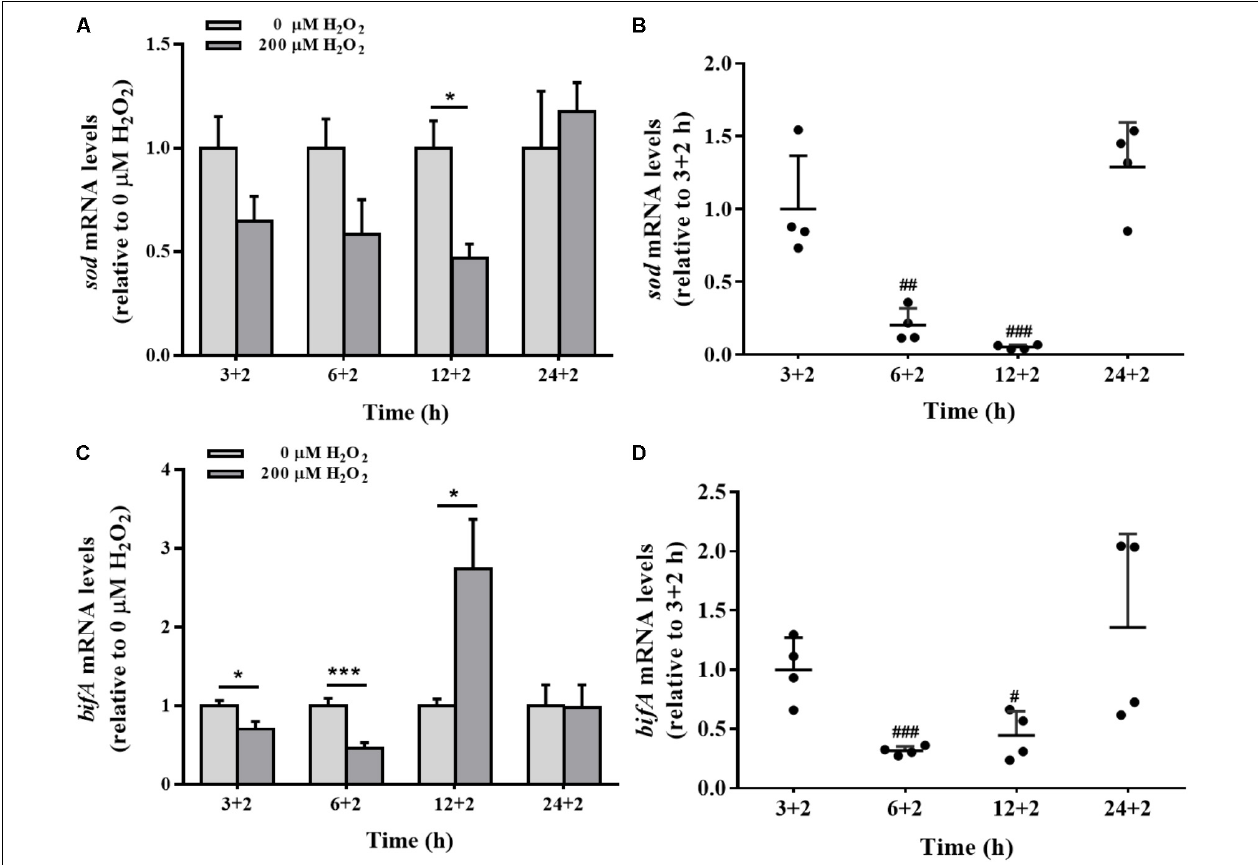
FIGURE 6 | The sod and bifA mRNA levels in biofilm cells as well as during biofilm development with exogenous H 2 O 2 . sod (A) and bifA (C) mRNA levels were detected by qRT-PCR analysis in colonized cells incubated with 200 µ M H 2 O 2 for 2 h after 3 h, 6, 12, and 24 h cultivation for adhesion, respectively. Relative gene expression levels of sod and bifA were normalized to 16s rRNA ( n = 4), respectively. The cellular mRNA levels of sod (B) and bifA (D) during different stages of biofilm formation. Data were expressed as mean ± SEM. Significance, ∗ P < 0.05, ∗∗ P < 0.01, and ∗∗∗ P < 0.001 vs. control group (0 µ M H 2 O 2 ). # P < 0.05,